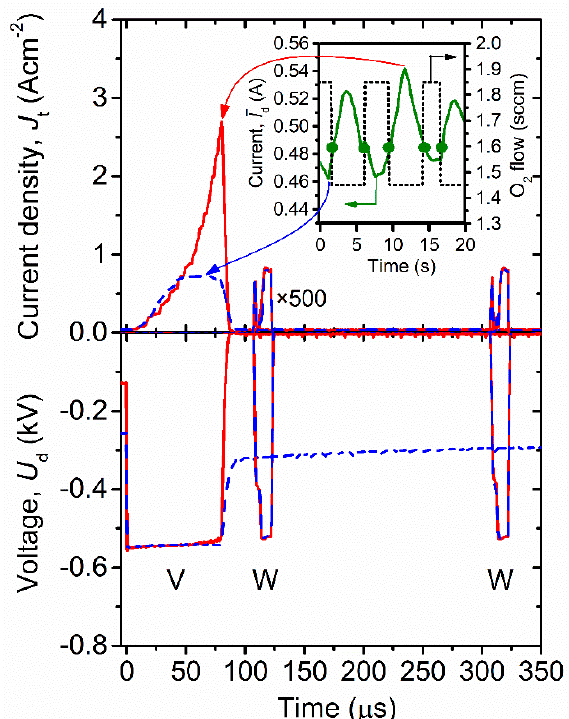
Figure 2. Waveforms of the magnetron voltage ( U d ) and the target current density ( J t ) for preset deposition-averaged target power densities of 13.5 Wcm − 2 and 35 mWcm − 2 for V and W target, respectively, during a deposition of the V 0.984 W 0.016 O 2 layers (the J t values for W target are magnified 500 times). Time evolution of the average discharge current on the V target in a period of its power supply ( 𝐼̅ d ) during the deposition is shown in the inset. A pre-selected critical value ( 𝐼̅ d ) cr = 0.485 A determining the switching between the oxygen flow rates Φ ox = 1.45 sccm and Φ ox = 1.85 sccm is marked by dots.